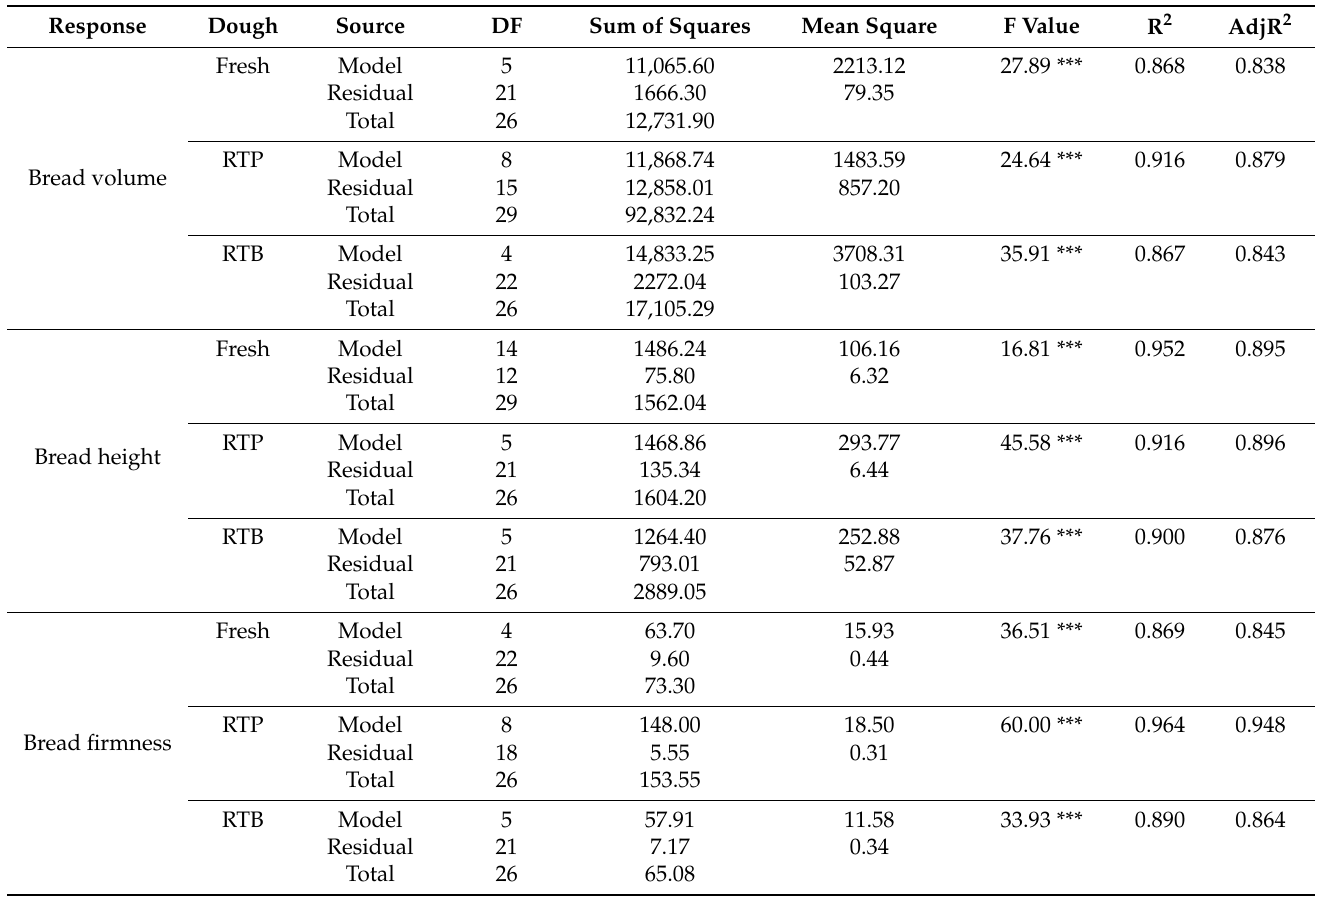
Table 4. Analysis of variance of the response surface quadratic or reduced quadratic models for volume, height, and firmness of bread made with each frozen dough.